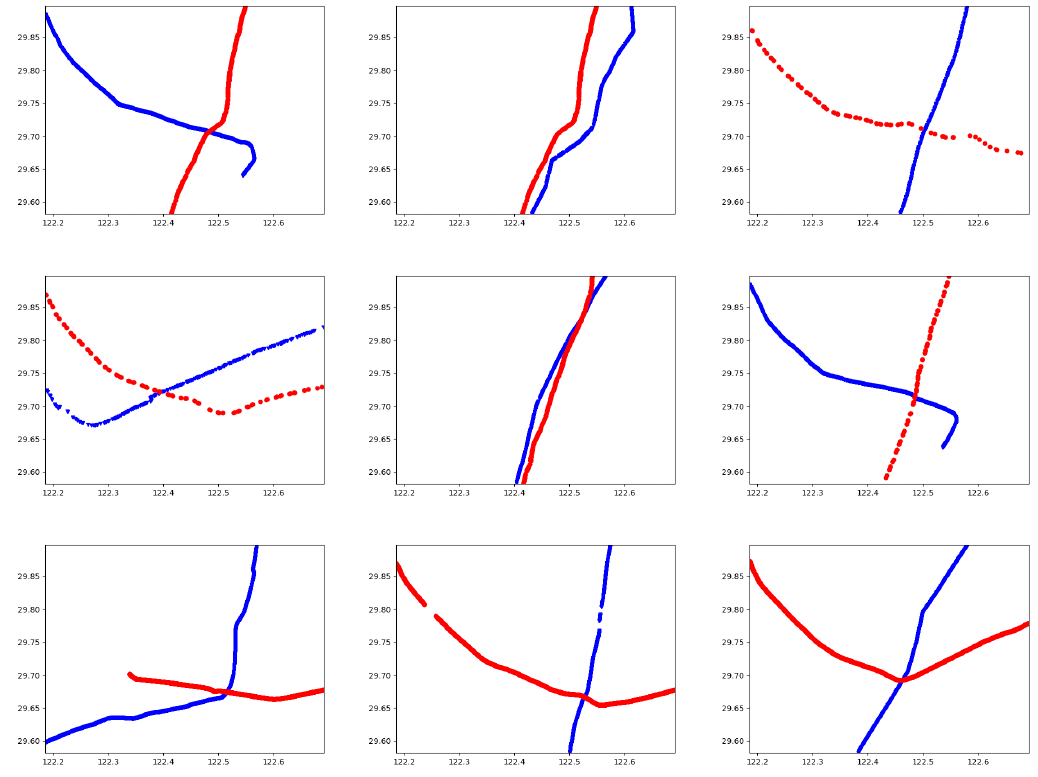
Figure 19. Double GRU-RNN training data preparation.